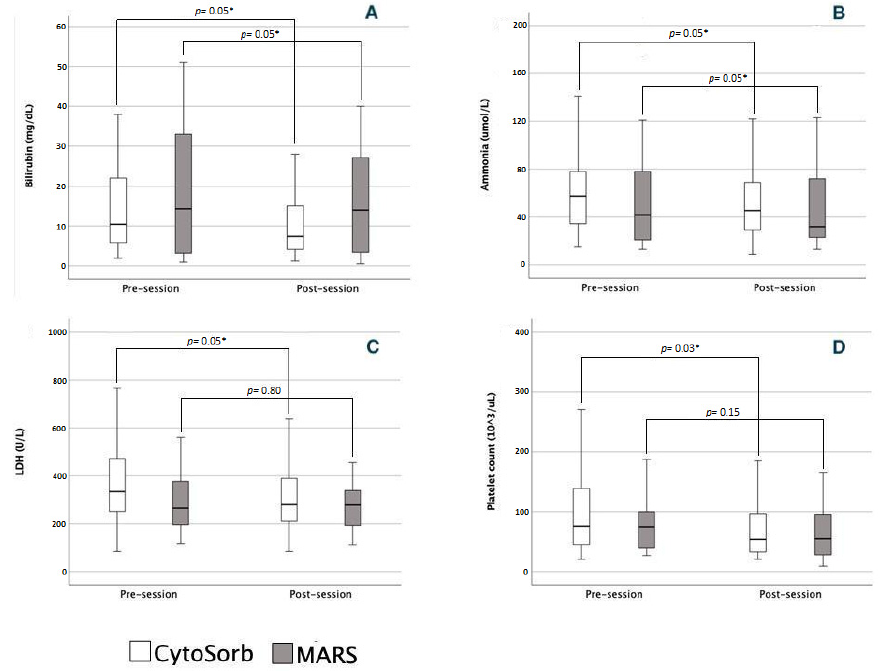
Figure 1. Comparison of biochemical parameters before and after a single session of liver support therapy. ( A ) Bilirubin; ( B ) ammonia; ( C ) lactate dehydrogenase; ( D ) platelet count. A session has been defined as a single session of extracorporeal liver support. * denotes a p value < 0.05.